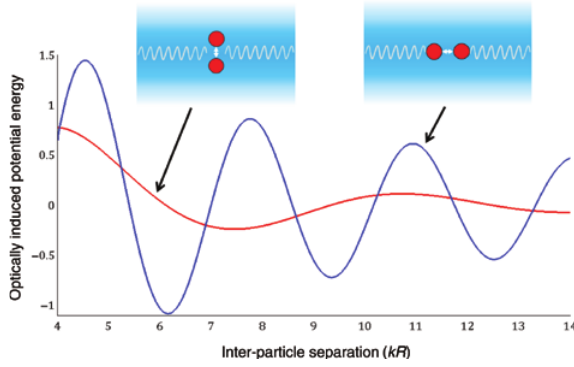
Figure 2: Graph of optically induced potential energy (with arbitrary scale) against inter-particle separation measured in terms of kR , for longitudinal (blue line, as depicted in inset diagram) and transverse (red line, also shown) optical binding; k is given a typical value of 3 × 10 −7 m −1 . Notice that both oscillating curves are damped as the separation distance